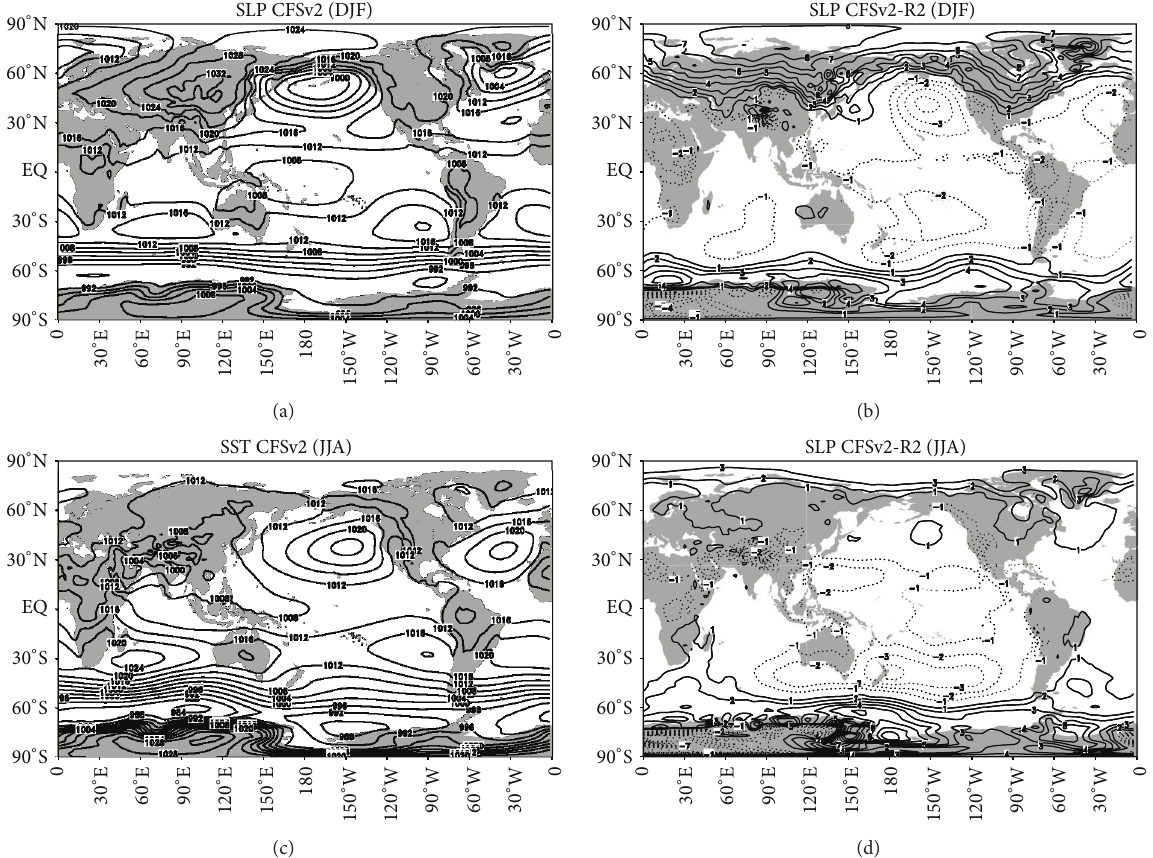
Figure 5: Mean CFSv2 sea level pressure ((a) and (c)) and differences from R2 ((b) and (d)) during DJF ((a) and (b)) and JJA ((c) and (d)) at 0-month lead. The climatology period is 1983–2010. Contours interval is 4 hPa in (a) and (c) and 1hPa in (b) and (d). Negative contours are